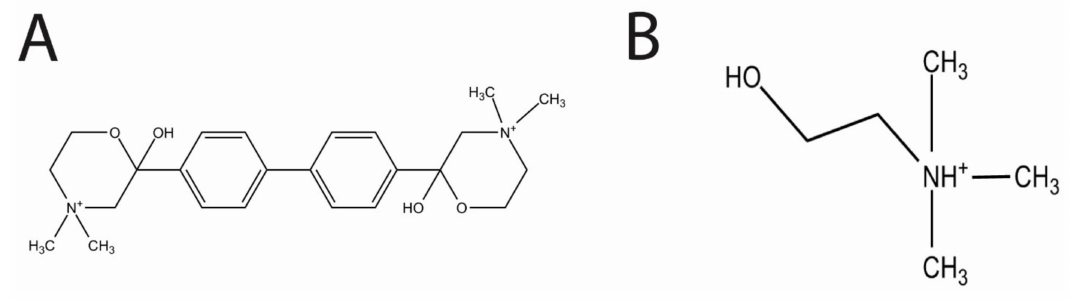
Figure 1. The respective structures of Hemicholinium-3 (HC-3) ( A ) and choline ( B ). The two methyl groups of HC-3 mimic the methyl groups found in